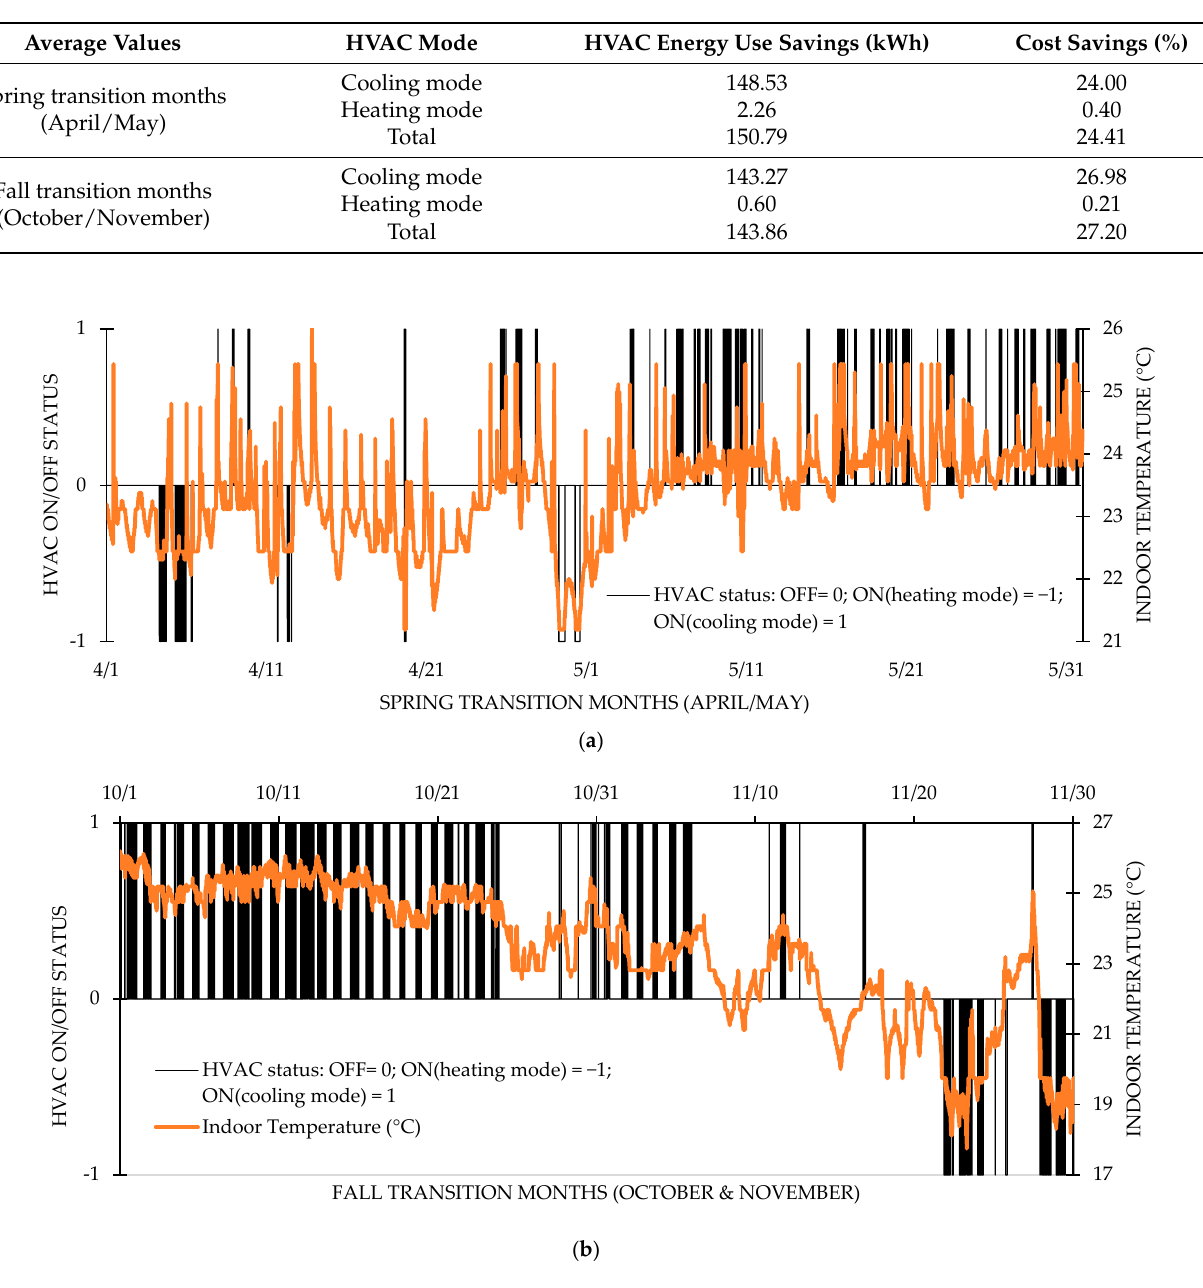
Table 3. Energy and economic benefit evaluation.